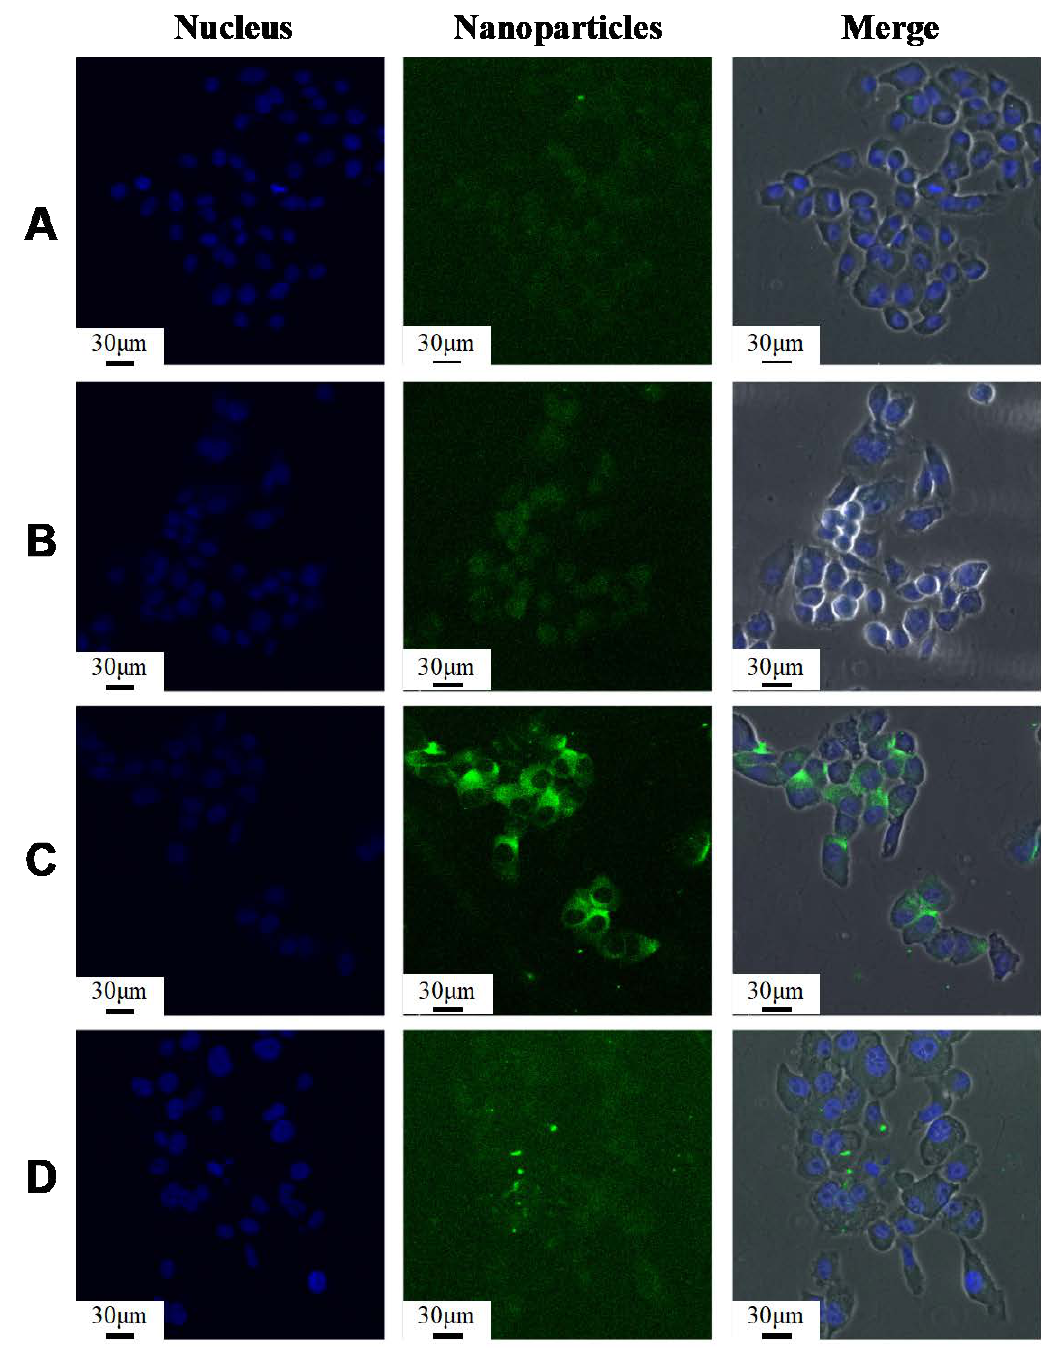
Figure 6. Confocal microscopy studies in PC-3 cells treated with ( A ) mPEG-PPADT, ( B ) mPEG-PPADT pretreated with free BBN, ( C ) BBN-PEG-PPADT, and ( D ) BBN-PEG-PPADT pretreated with BBN. Nuclei and nanoparticles were labeled with DAPI (blue) and FITC (green), respectively.